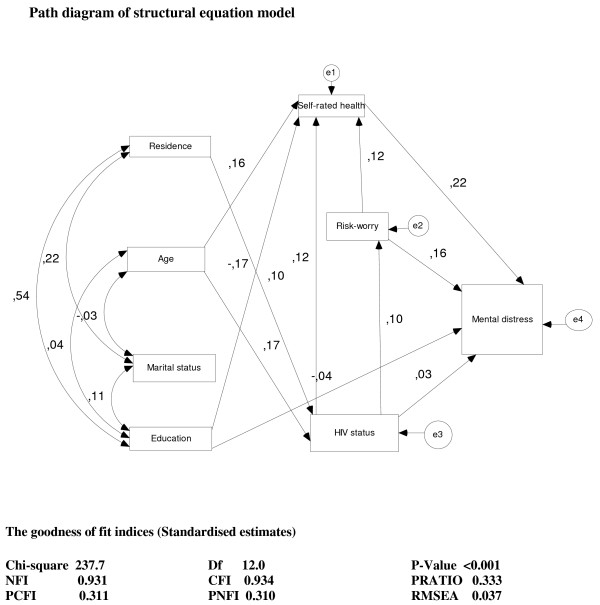
Significant pathways of the final model and goodness-of-fit indices. DF = degrees of freedom, NFI = Normed fit index, CFI = comparative fit index, PRatio = Parsimony ratio, PCFI = parsimony comparative fit index, PNFI = parsimony Normed fit index, RMSEA = Root mean square error approximation.